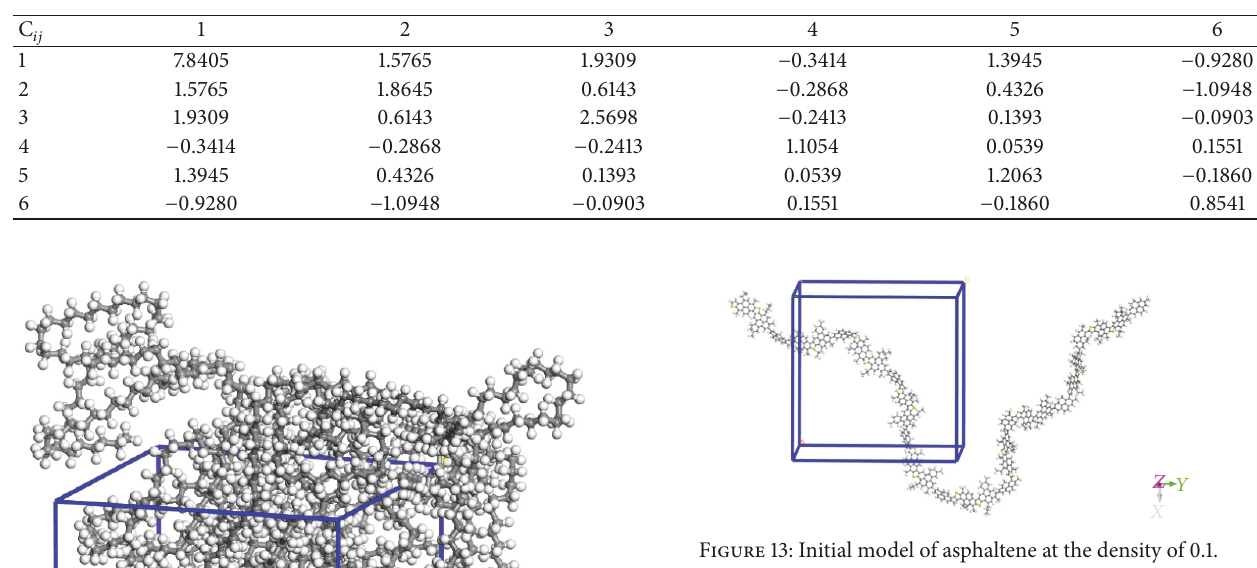
Table 3: Stiffness matrix obtained for asphaltene model.